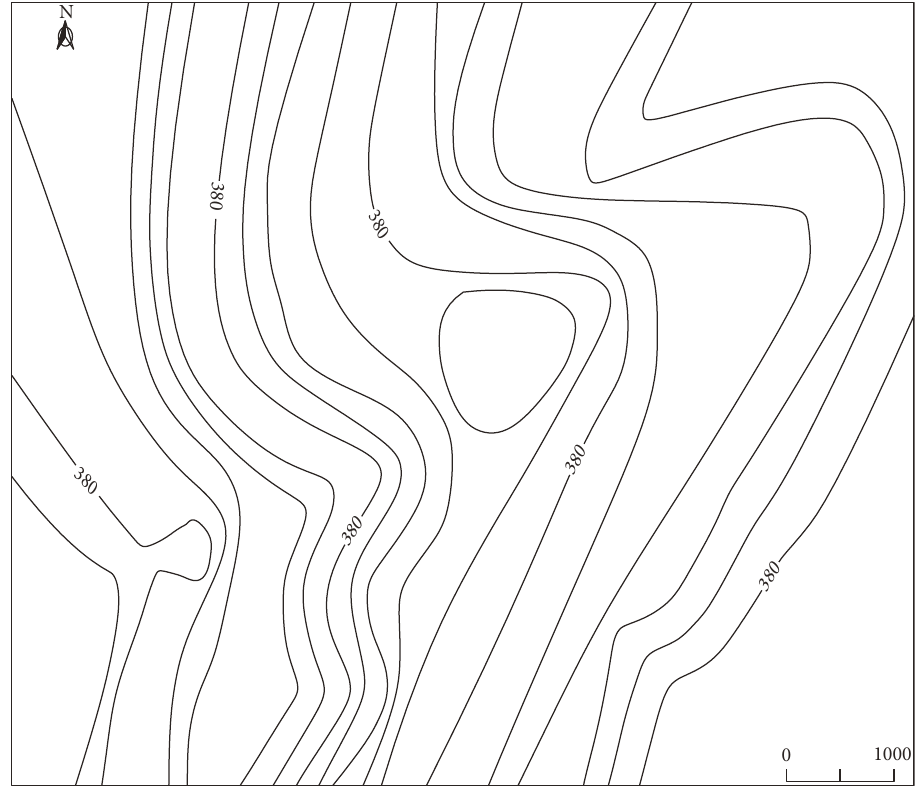
Figure 9: The structural features of the coal seam at key moments in the early Himalayan